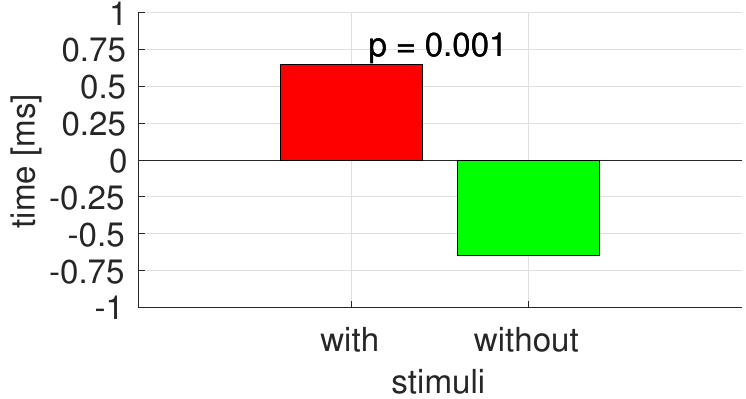
Figure 6. The difference in mean time reaction between situation with stressful stimulus (red) and without stressful stimulus (green). The p -value indicates the statistical difference between compared stimuli, computed by the Kruskal–Wallis test at a 0.05 significance